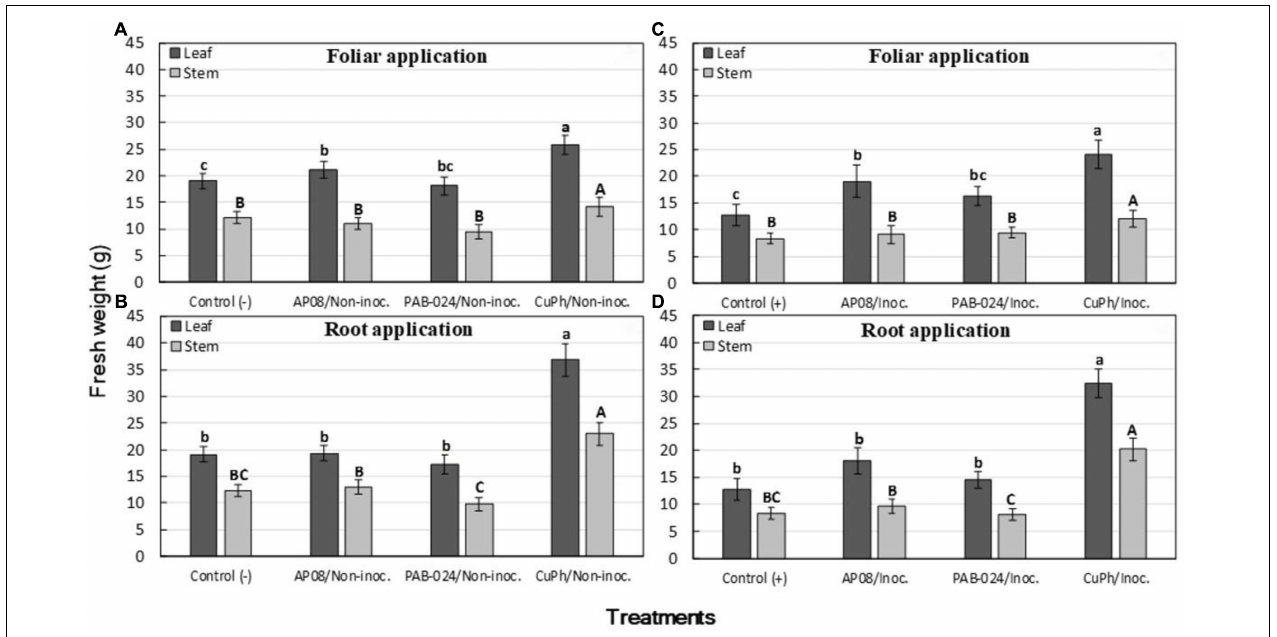
FIGURE 1 | Effect on plant biomass [fresh weight (g) of leaves and stem] in olive plants of cv. Picual, noninoculated (A,B) or inoculated (C,D) with Verticillium dahliae , 3 months after treatment by spray (foliar application) or irrigation (root application) with the following products: water [Control: (–) = noninoculated control; (+) = inoculated control), Aureobasidium pullulans (AP08), Bacillus amyloliquefaciens (PAB-024) or Copper Phosphite (CuPh). In each graph, columns represent the mean of 30 plants (two experiments with three replicated blocks and five plants per block). Columns with a common uppercase or lowercase letter do not differ significantly according to Fisher’s protected LSD test at P = 0.05 for fresh weight of stem and leaf tissues, respectively. Vertical bars are the standard error of the means.